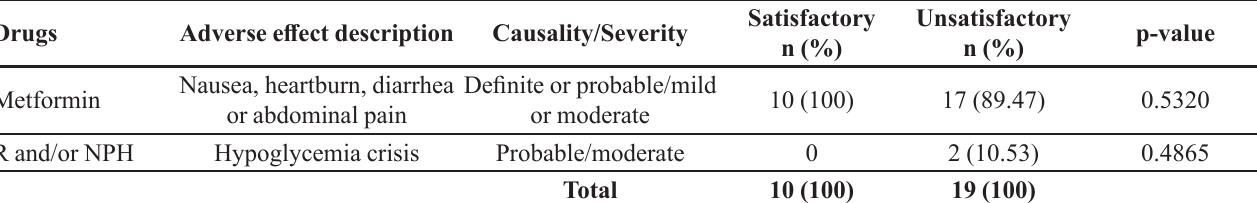
TABLE V - Characterization of adverse drug reactions according to glycemic control Drugs Adverse effect